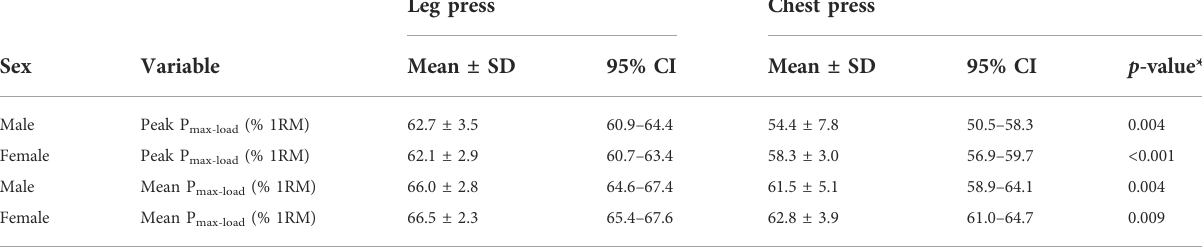
TABLE 2 Differences between leg press vs. chest press using the peak P max-load and mean P max-load in both sexes.